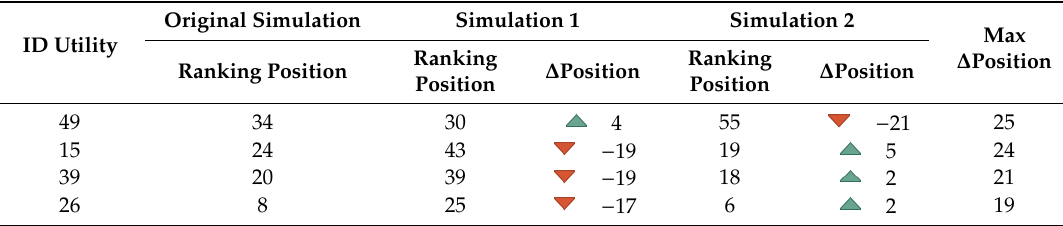
Table 3. Example of variation of utilities in the ranking.